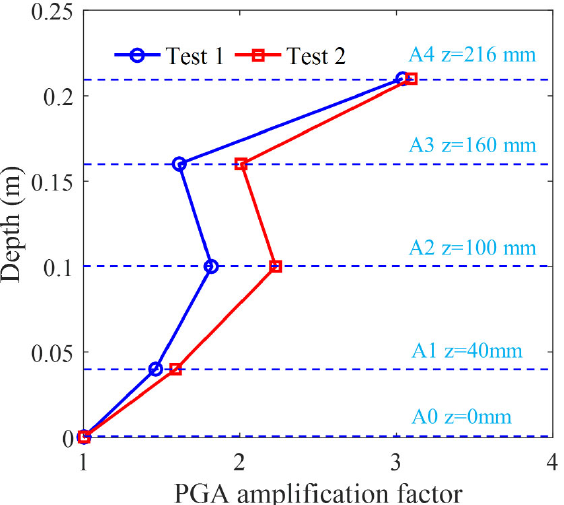
Figure 14. Distribution of the amplification factor of seismic acceleration along the model height in Test 1 and Test 2 (only in horizontal).